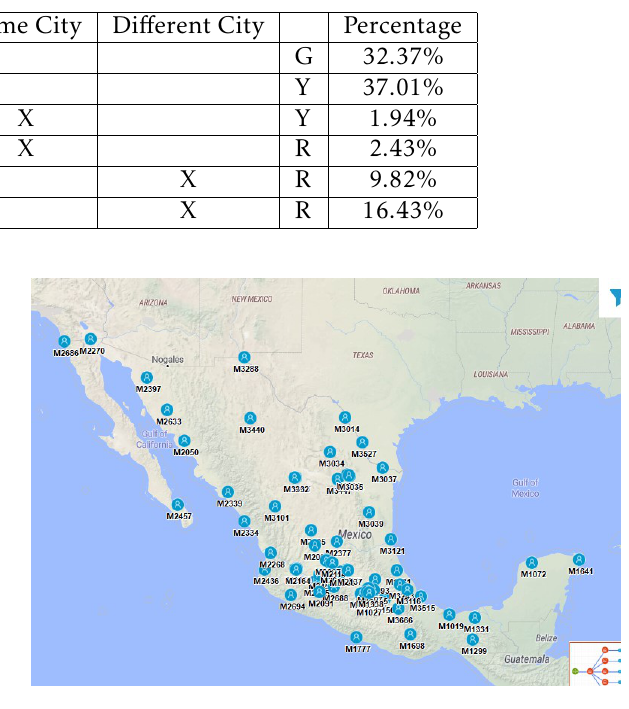
Figure 3. Dealers automotive